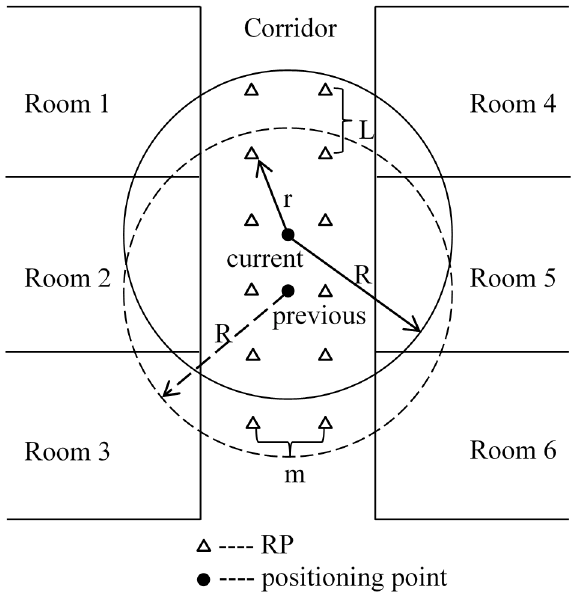
Figure 3. Moving partition.